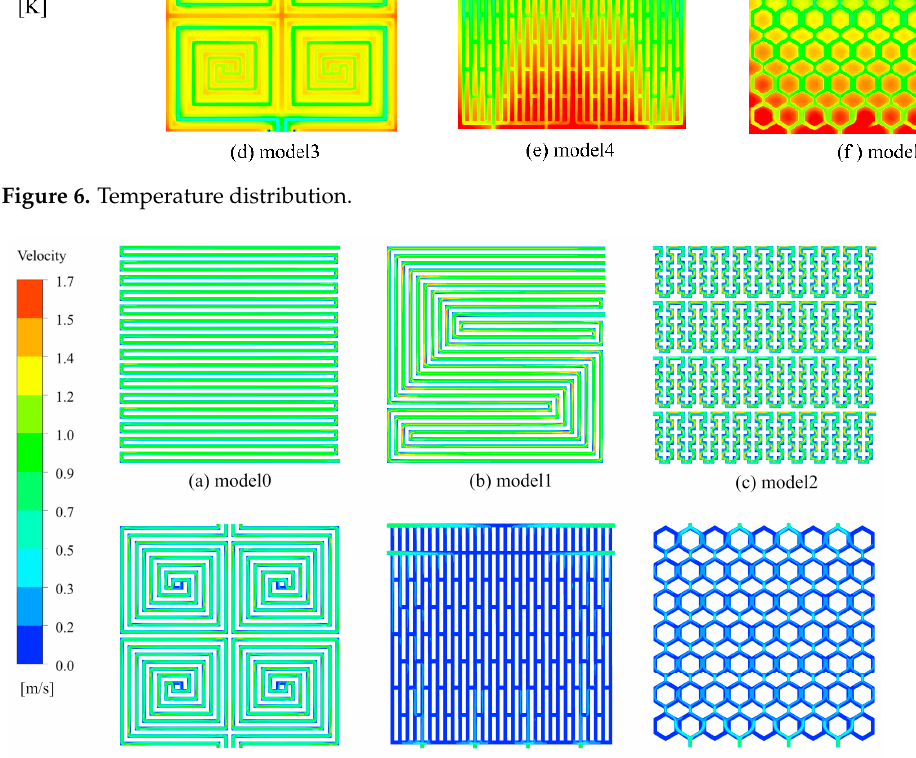
Figure 7. Velocity